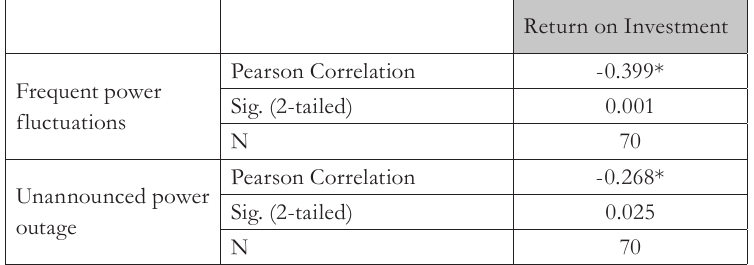
Tab. 5 - Correlations between Power fluctuations and Return on Investment (ROI). Source: Survey data,